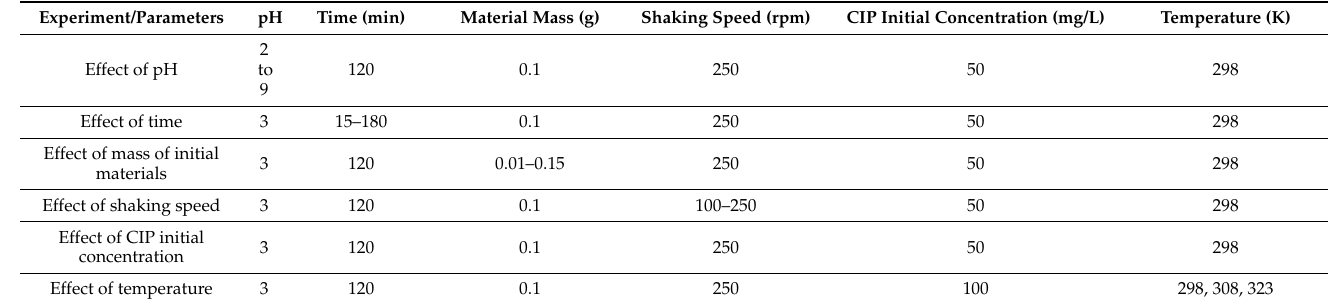
Table 1. Parameters in the